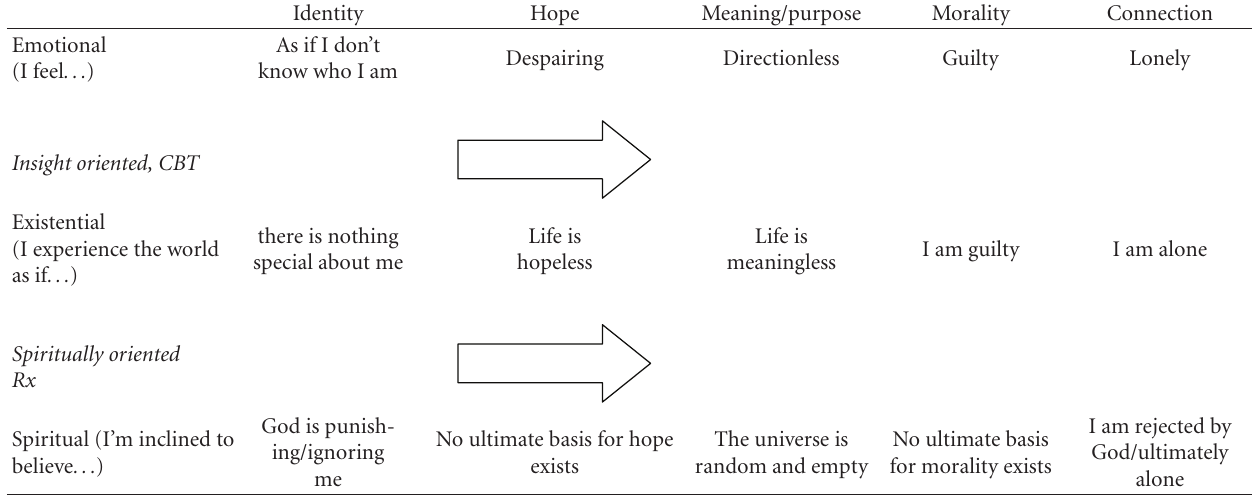
Table 1: A framework for intervention.